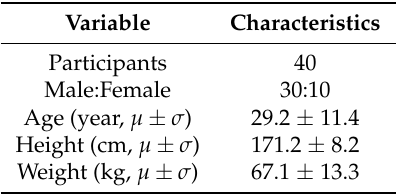
Table 3. Characteristics of the